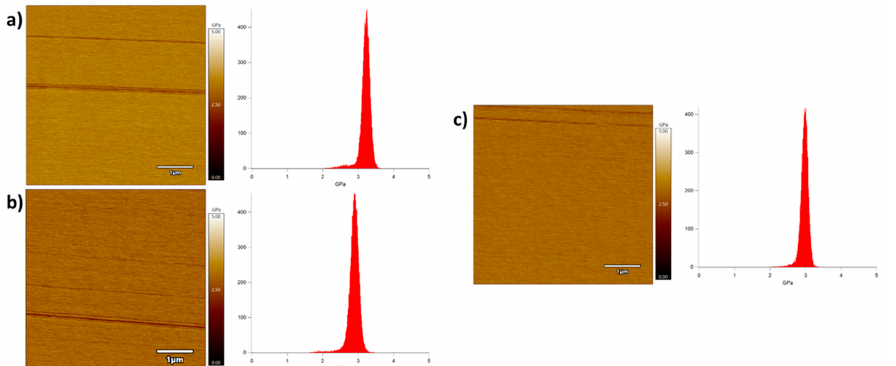
Figure A31. AFM-AM-FM modulus images and respective histograms of ( a ) poly(4DTP-fa), ( b ) poly(4DPDS-fa), and ( c ) poly(3DPDS-fa). Images depict an area of 5 × 5 μ m 2 .